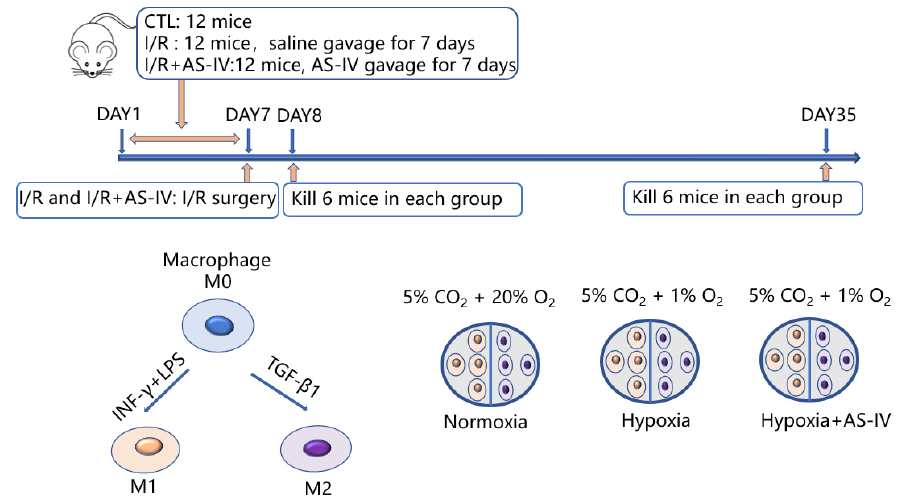
Figure 1. Schematic flowchart of the experimental design.